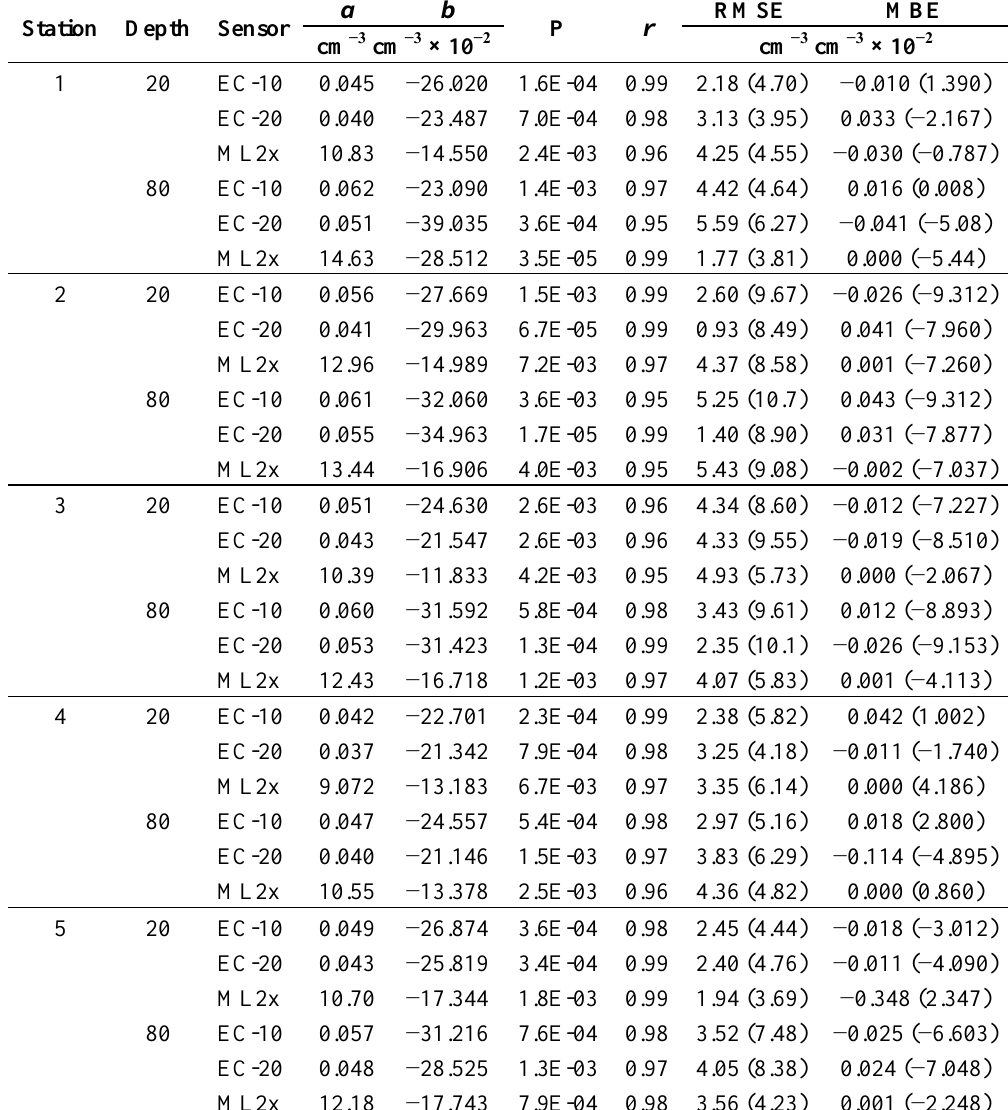
Table 4. Calibration functions of EC-10, EC-20, and ML2x laboratory calibration equations and statistical indicators for their accuracy in estimating actual water